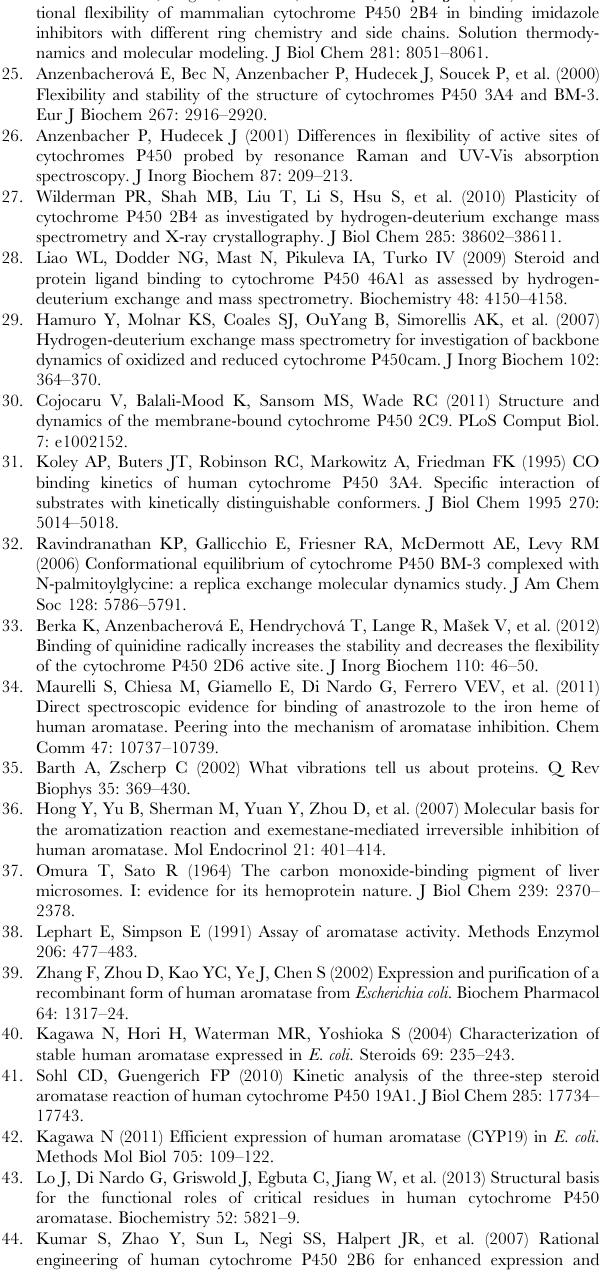
fitting to a biphasic exponential decay (R 2 = 0.9865) and a monophasic exponential decay (dashed line, R 2 =0.8322). (TIF) Table S1 Chi-square values of the fitting of the time resolved fluorescence data to different exponential